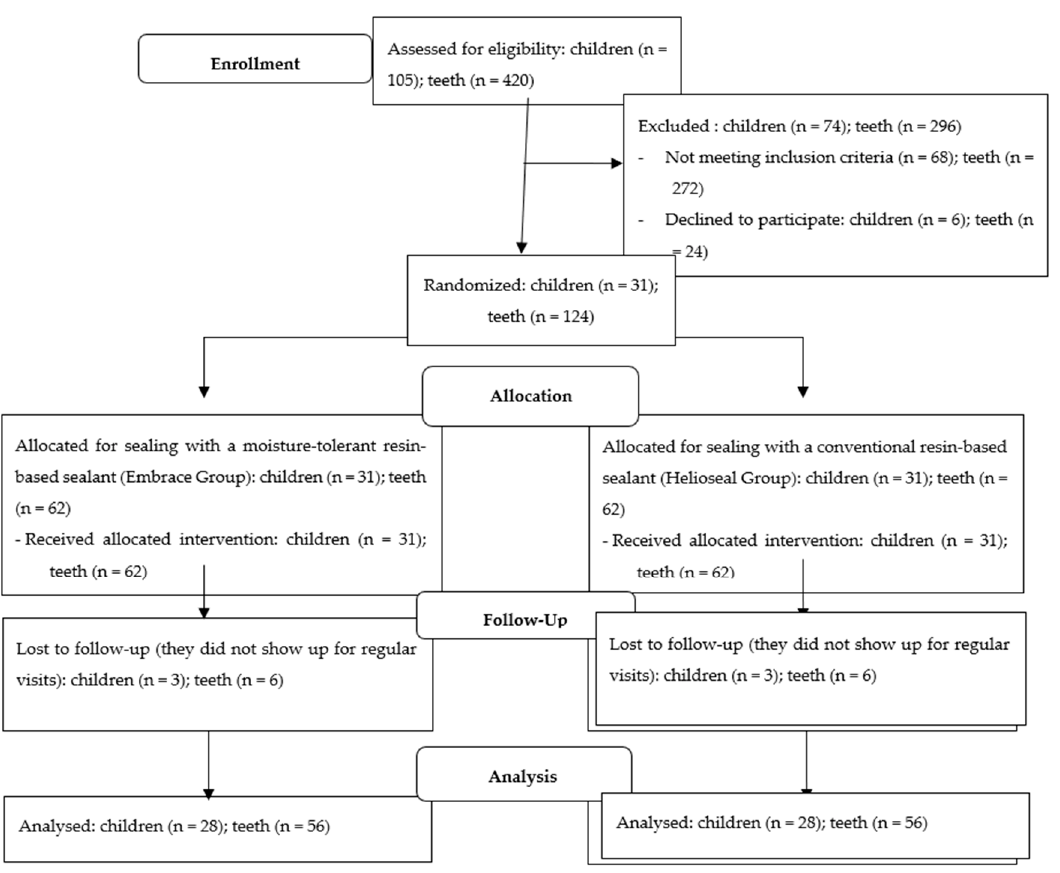
Figure 1. Consort flow diagram for the study.